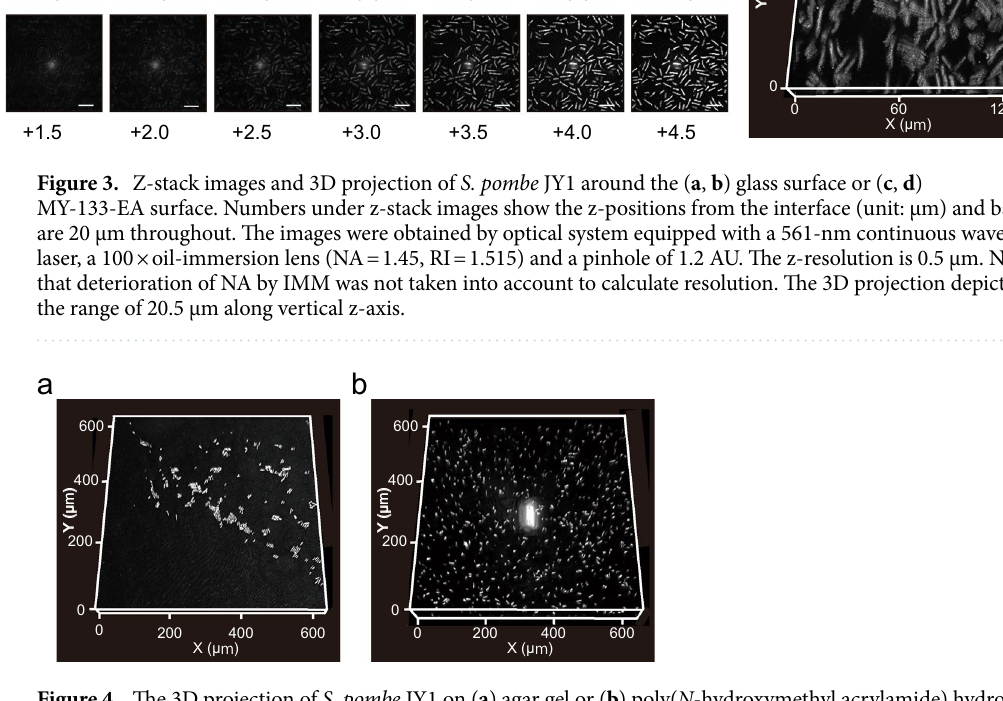
Figure 4. The 3D projection of S. pombe JY1 on ( a ) agar gel or ( b ) poly( N -hydroxymethyl acrylamide) hydrogel surface. The images were obtained by optical system equipped with a 561-nm continuous wave laser, a 20 × dry lens (NA = 0.75, RI = 1.0) and a pinhole of 1.2 AU. The z-resolution is 2.8 μm. The projection of ( a , b ) depicts the range of 33 and 102.5 μm of height along the vertical z-axis,